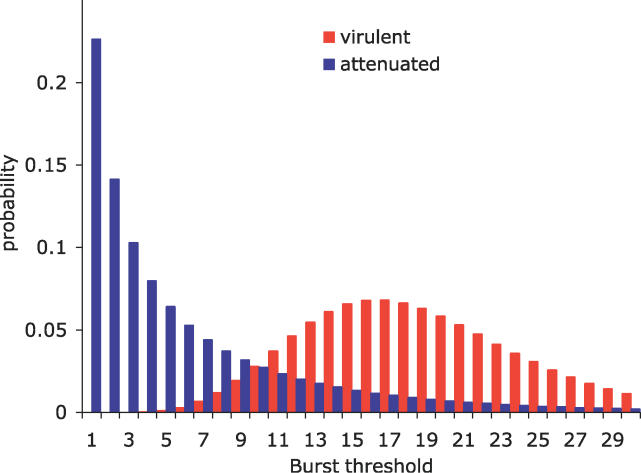
Burst Threshold DistributionsInferred from stationary distribution of bacterial charges, assuming a gamma distribution of burst thresholds (parameter values in Table 1).